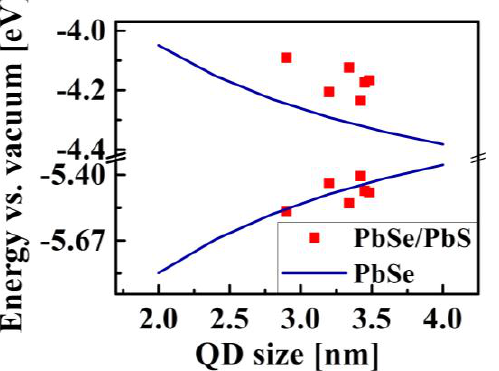
Figure 14. Absolute positions of the lowest quantized levels in PbSe and PbSe/PbS core/shell QDs of various size.